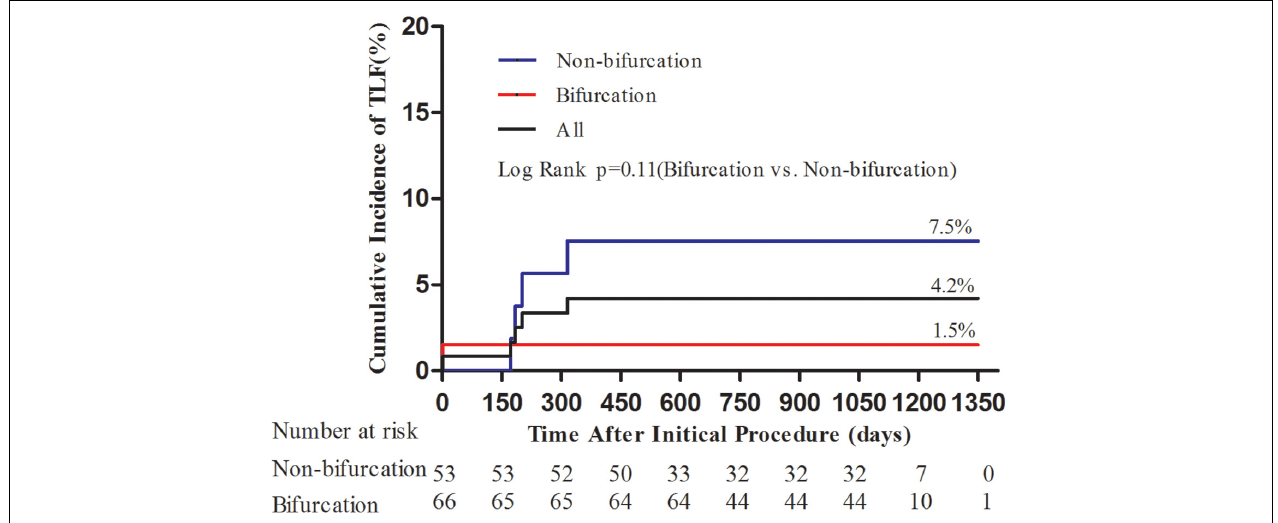
FIGURE 1 | Kaplan–Meier curves for cumulative incidence of target lesion failure (TLF). Kaplan–Meier curves showed numerically lower TLF in the bifurcation group; however, it was not statistically different ( p = 0.11).